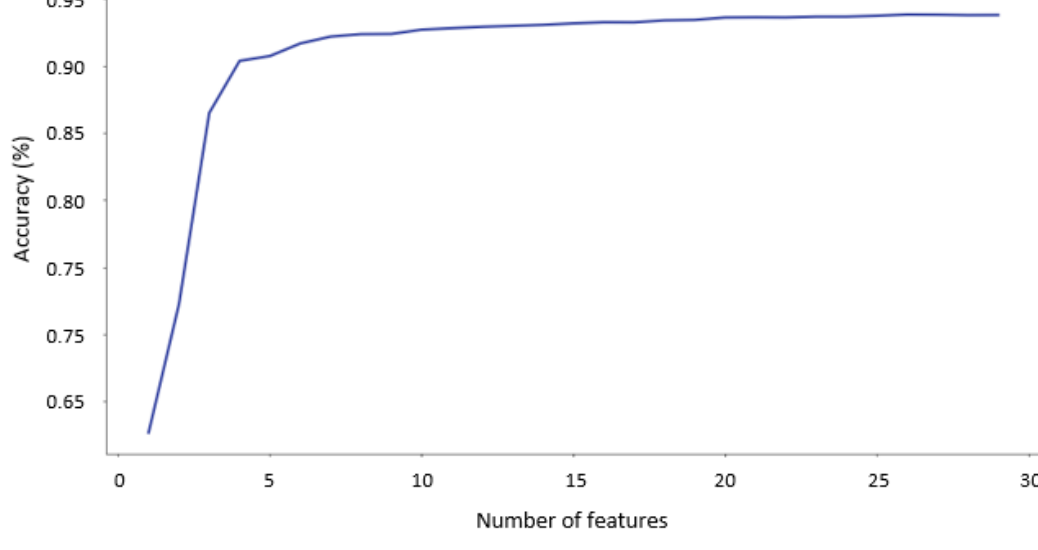
Figure A1. Plot of accuracy versus number of features.